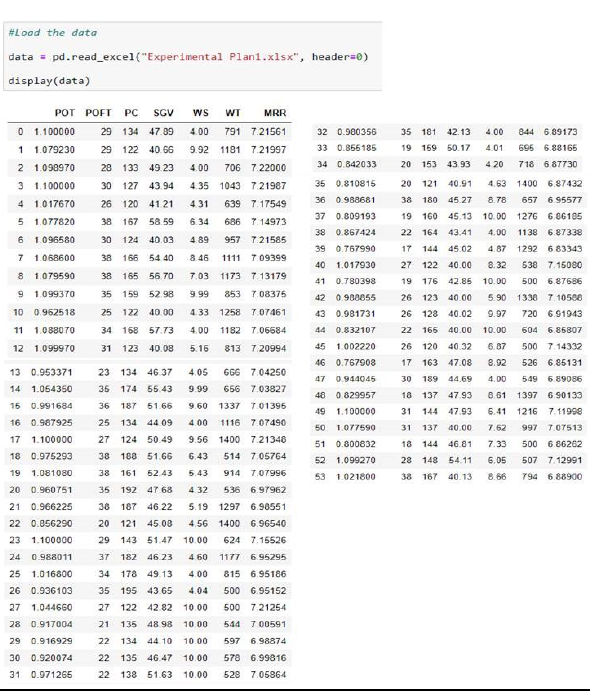
strated in Table 7. In the final step, the trained model to predict the optimal data for MRR as shown in Table 8. Fig- ure 8a shows the heat map and co-relation matrix for each dataset. Besides this algorithm which was applied to pre- dict the optimal values for MRR as shown in Figure 8b. It shows a good agreement with the actual and predicted val- ues.